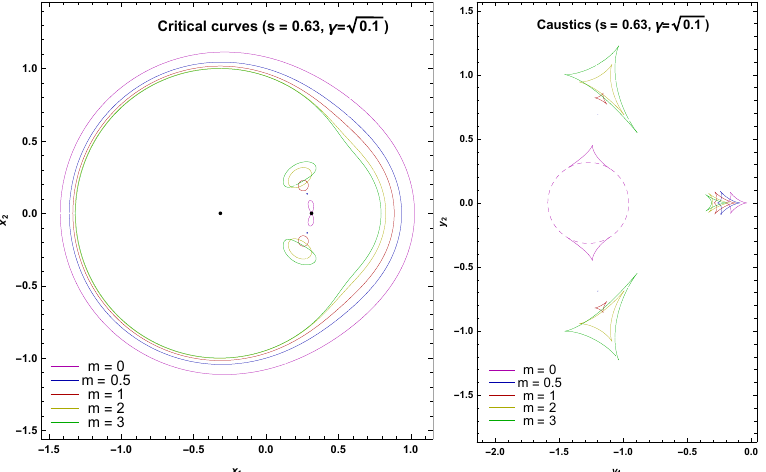
Figure 11. Critical curves and caustics in the unequal-strength binary, close separation. The dashed magenta circle indicates the pseudocaustic for m = 0.